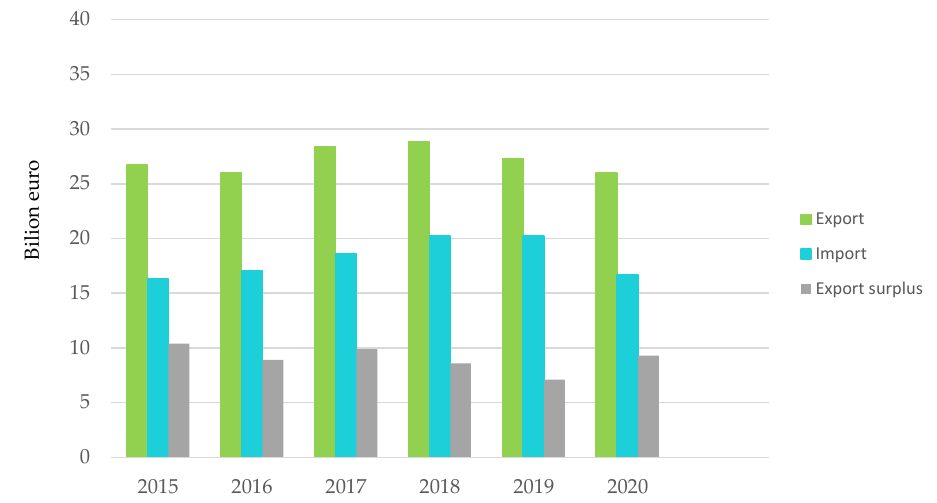
Figure 2. Plastics production and trade balance with non-EU27 countries. Made based on [3].